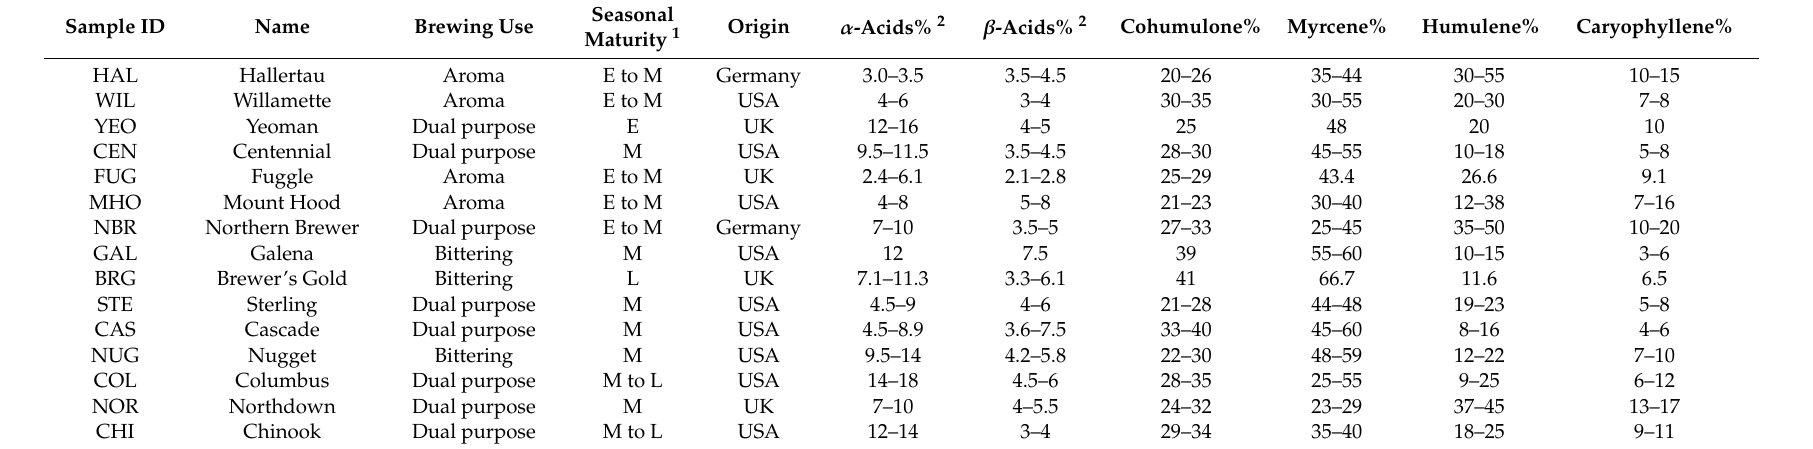
Table 1. List of hop varieties used for the experiment, their brewing use, maturity timelines, origin, and chemical characters